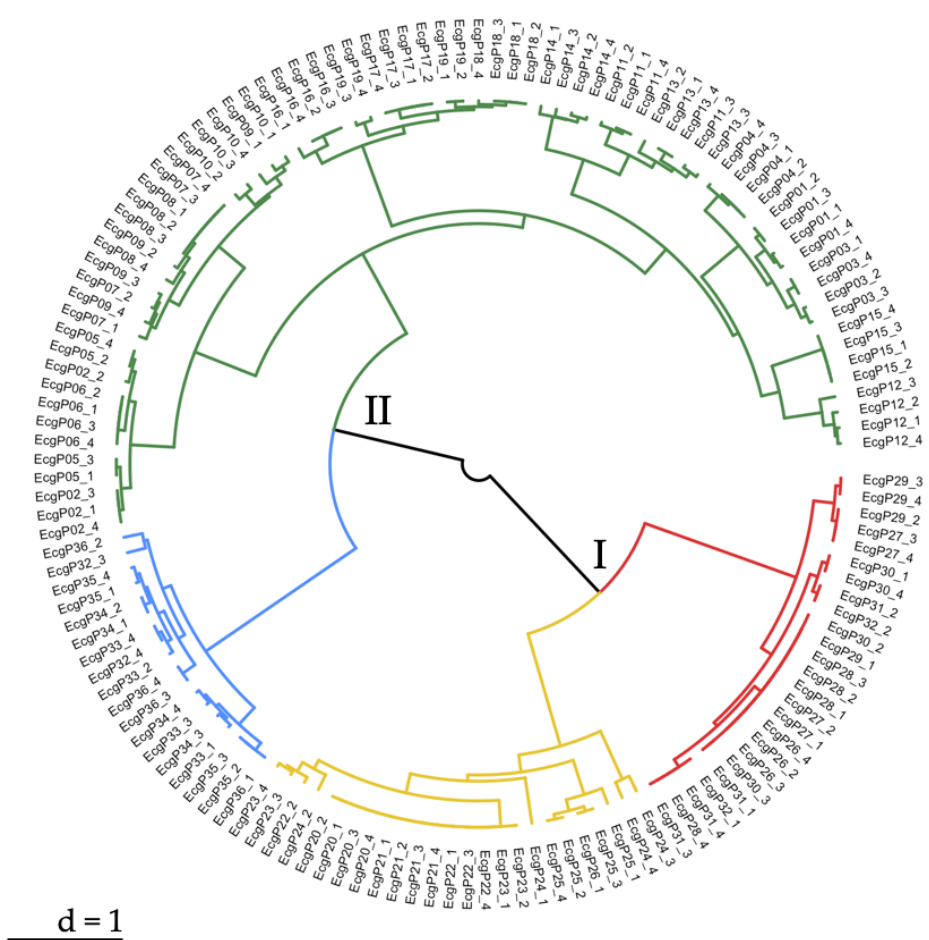
Figure 3. Ward.D2 hierarchical clustering based on Simple Sequence Repeats in Echinochloa crus-galli . Cluster I (red and yellow) = specimens collected from experimental parcels where only pre-emergent weed control was applied. Cluster II (blue and green) = specimens collected from experimental parcels where conventional weed control was applied.